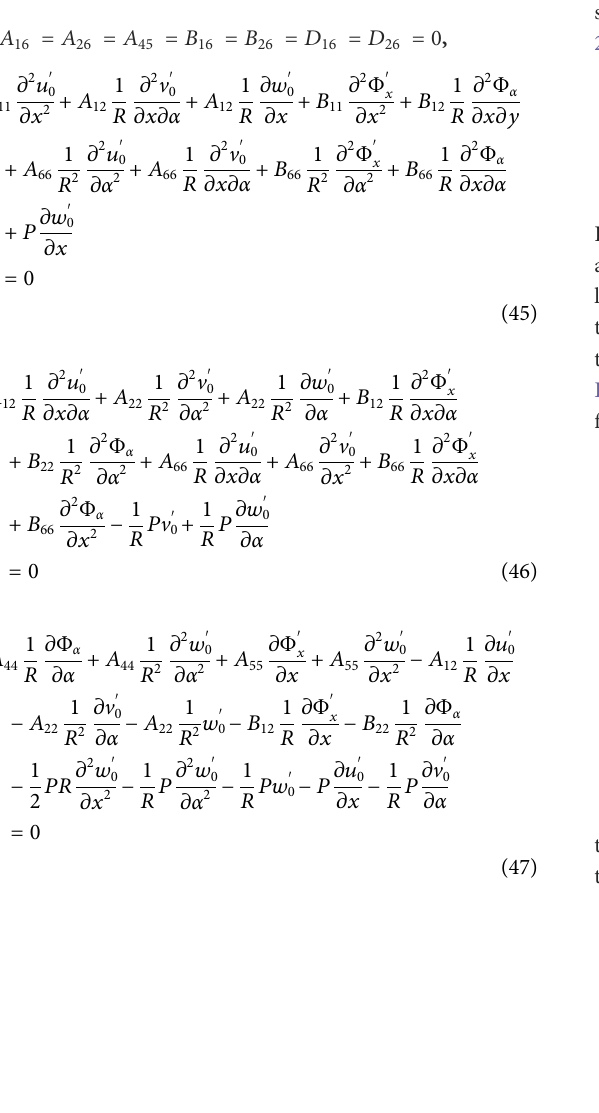
The general form of stability equations is achieved in Equations 40 – 44 for the composite submersible cylindrical shell with closed ends under hydrostatic pressure. The stability equations will be further simpli fi ed for cross-ply laminated cylindrical shells by putting the following relations to zero.